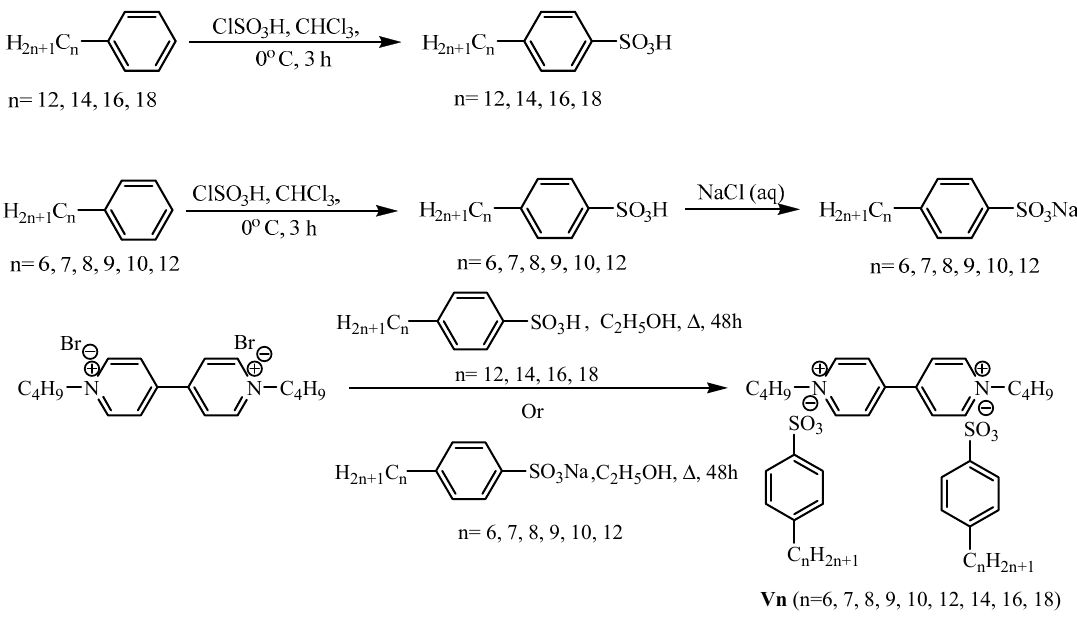
Figure 1. Some of the representative ILCs based on viologens that exhibits smectic phases and columnar LC phases depending on their chemical architectures.